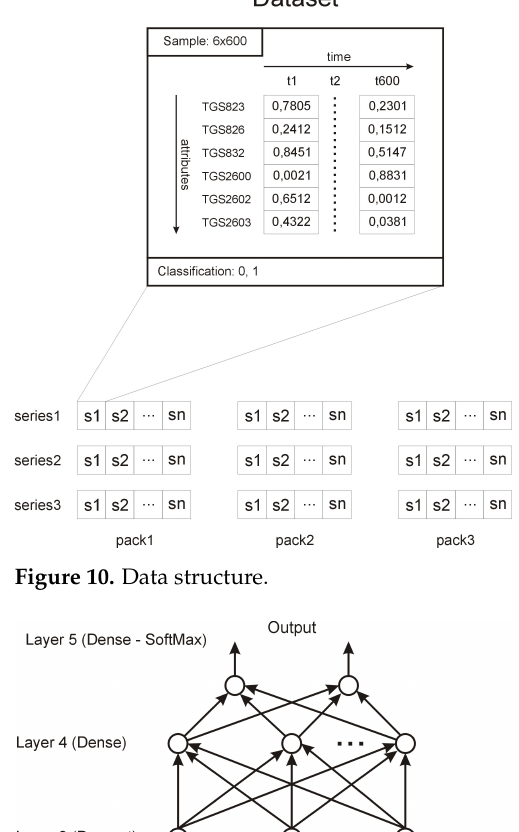
Figure 10. Data structure.